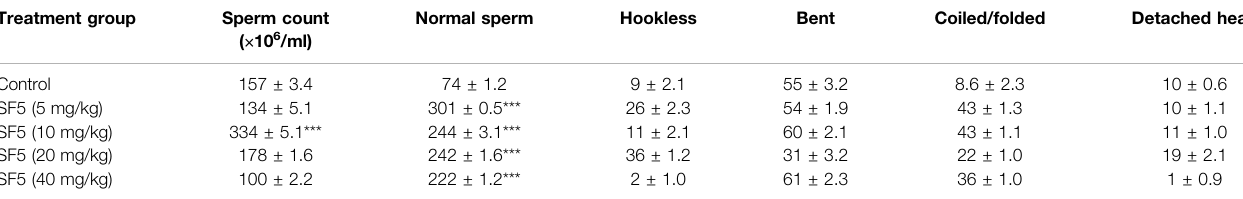
TABLE 8 | Effect of SF5 treatment at different dose levels on sperm count and its morphology. Treatment group Sperm count ( × 10 6 /ml)